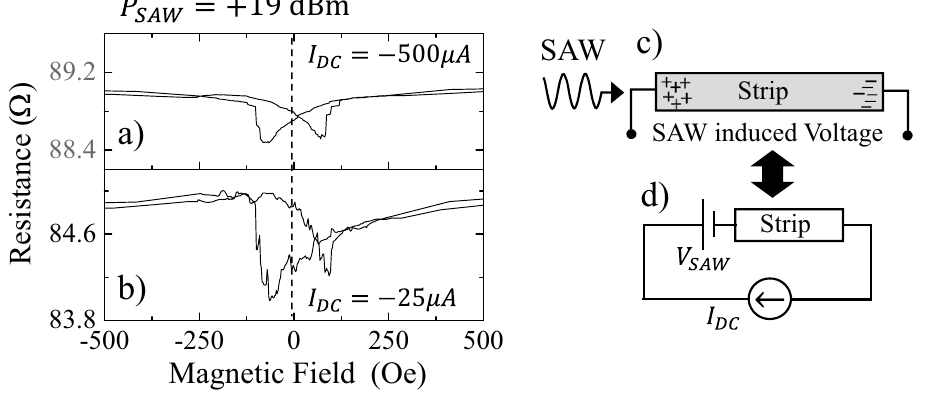
Figure 2. ( a ) AMR loop measured using a DC current of − 500 µA and in the presence of a 19 dBm SAW. ( b ) AMR loop using a DC current of − 25 µA and in the presence of a 19 dBm SAW. ( c ) Schematic representation of the acoustically induced voltage. ( d ) Equivalent circuit when measuring the resistance with a current source in the presence of an acoustically induced